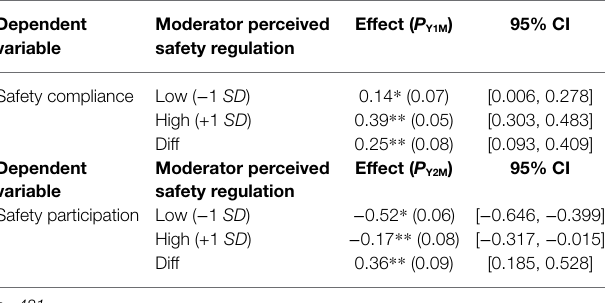
TABLE 4 | Moderation effect analysis.